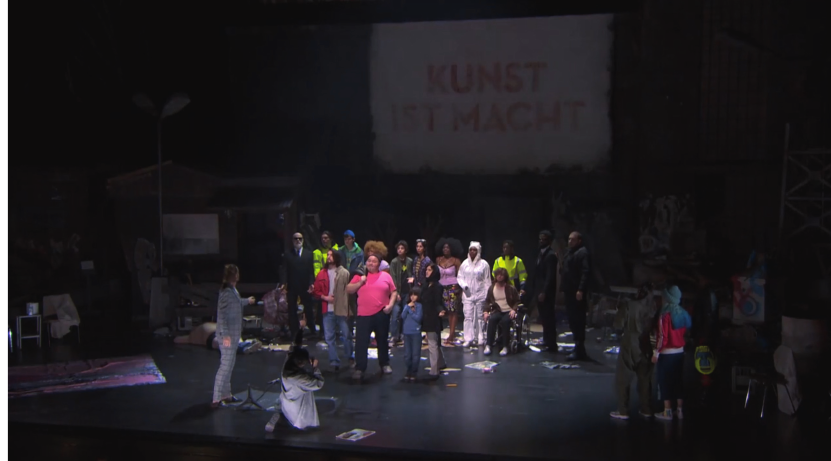
Fig. 2 Bernard Richter/Tito and Anna Goryachova/Sesto arranging a photocall while visiting the “Oth- er” side of the stage (act I, scene 4). Still frame from the streamed performance on GTG Digital (Feb- ruary 19,